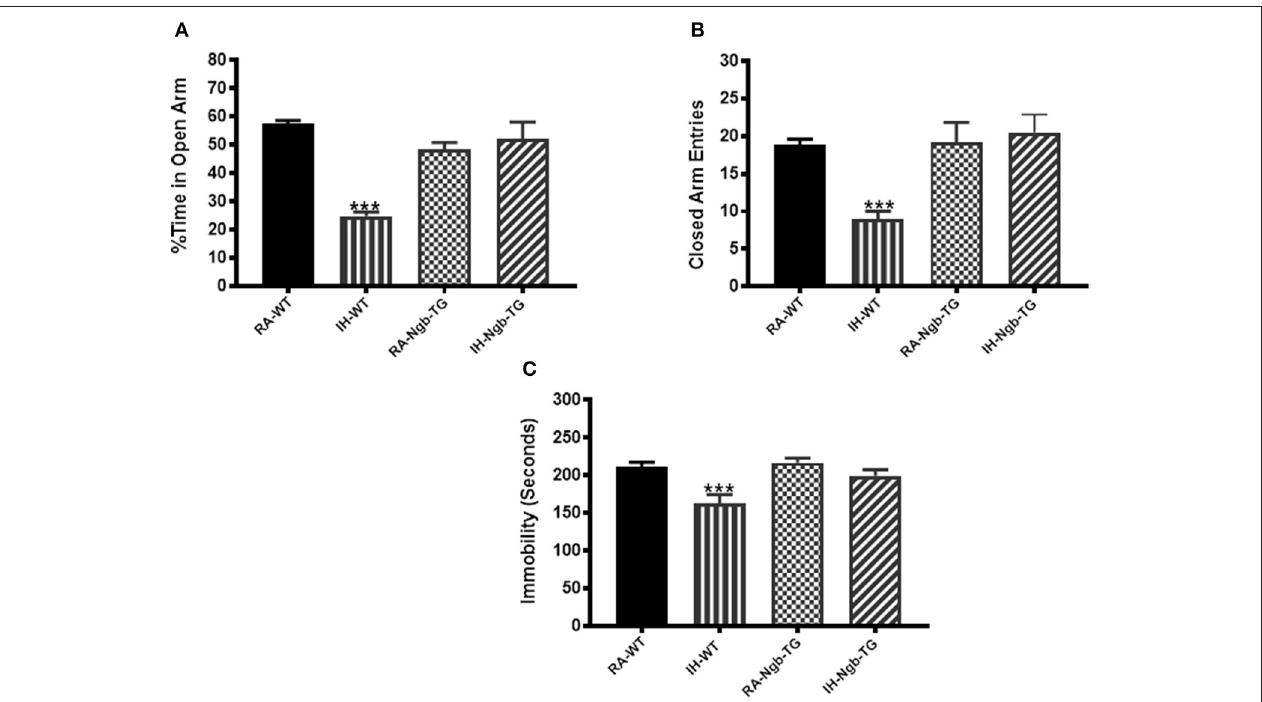
FIGURE 5 | Exposure to IH induces anxiety in mice, which is attenuated in Ngb-TG mice. WT mice exposed to IH spent significantly less time in the open arm of the elevated plus maze compared to RA-WT, or Ngb-TG mice exposed to either RA or IH (A) . A reduced number of closed-arm entries emerged in wild type mice exposed to IH (B) . ( n = 14/experimental group; *** P < 0.0001 vs. RA-WT) (C) Forced-swim test indicates Ngb-TG mice are not depressed following IH exposures. Ngb-TG exposed to IH show less immobility as compared to WT mice exposed to IH. ( n = 14/experimental group; *** P < 0.001 vs. RA-WT).